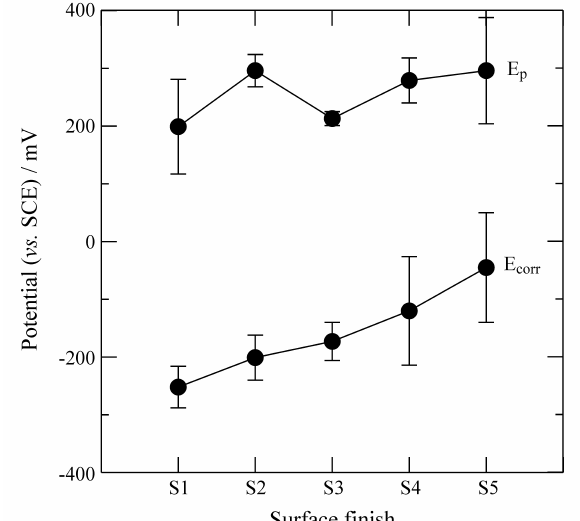
Figure 1. Pitting potential E p and corrosion potential E corr as a function of the surface finish for 304L